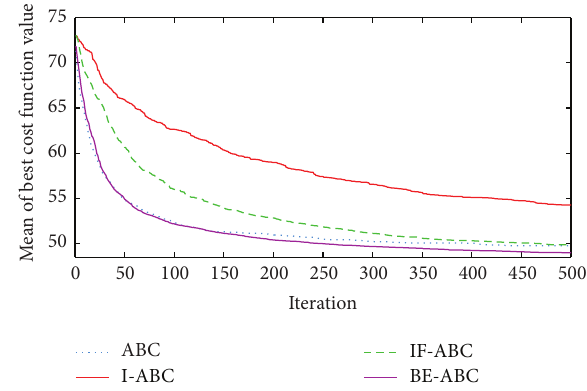
Figure 5: Comparative convergence curves of ABC, I-ABC, IF- ABC, and BE-ABC in Case 1 ( 𝐷 = 20 and MCN = 500 ).